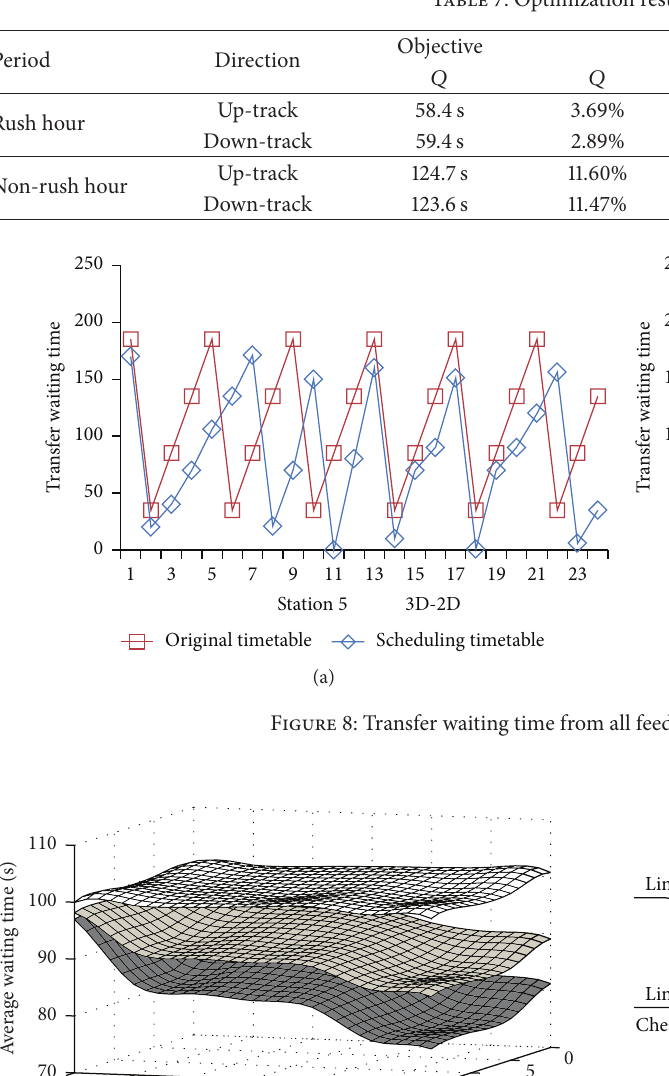
Table 7: Optimization results of Line 2.